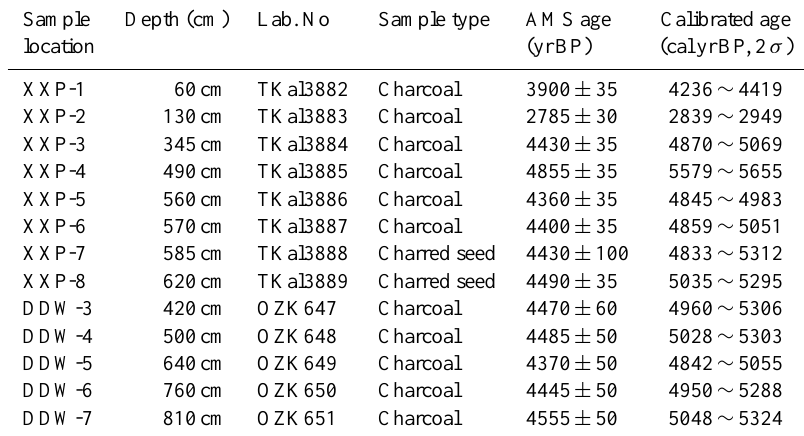
Table 1. Accelerator mass spectrometry (AMS) 14 C dates from the Xishanping and Dadiwan sites.